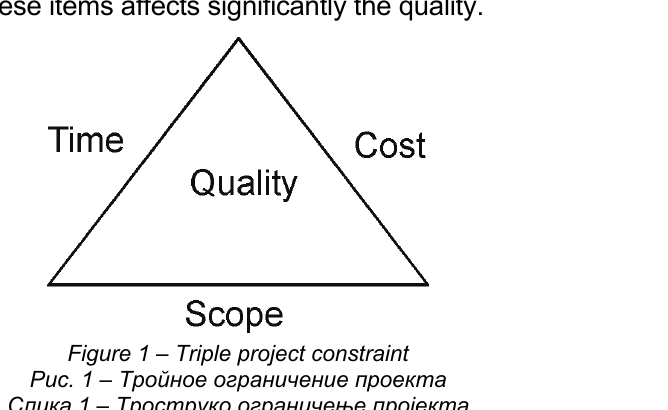
Figure 1 – Triple project